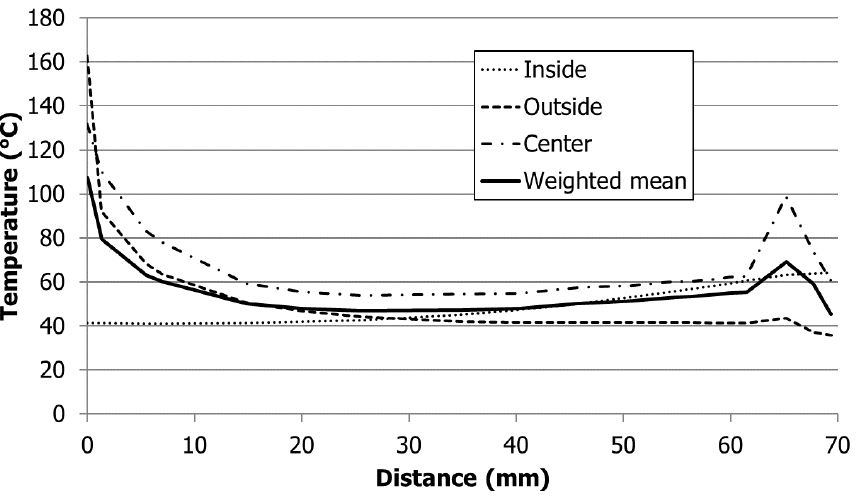
Figure 5. Simulated temperatures for a PP for the 1 mm box on a diagonal line from the center of the part to one corner at the inside surface, center and outside surface of the box and weighted mean temperature along the diagonal.